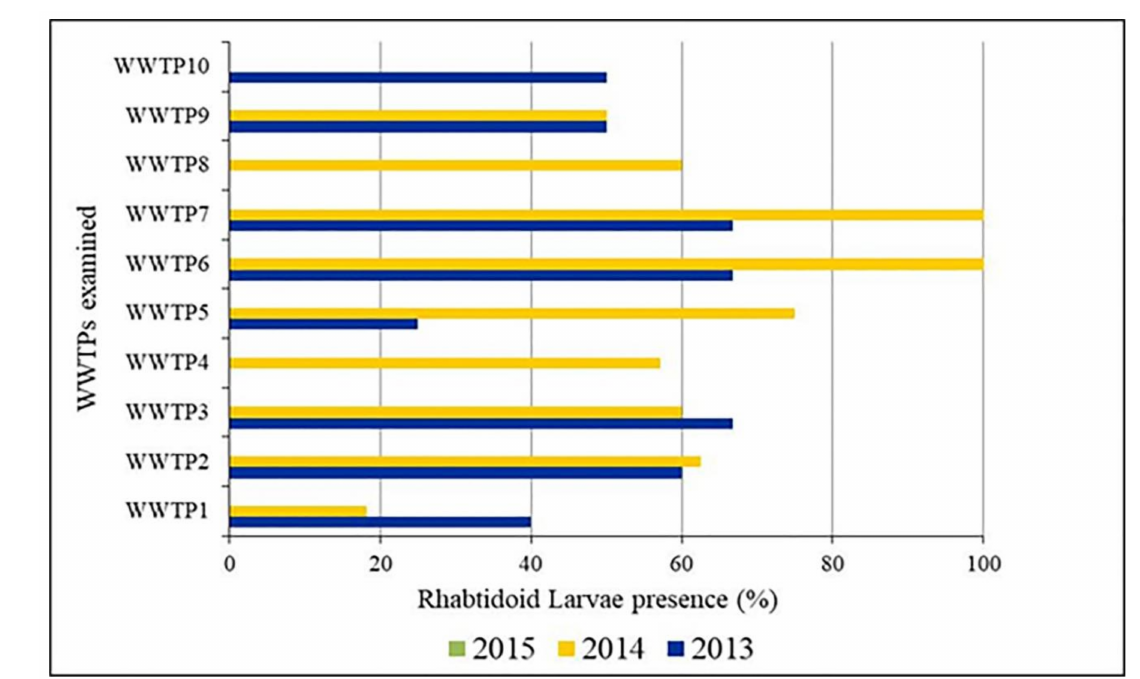
Figure 4. Percent presence of rhabditoid larvae of nematodes identified in dried sludge samples. During the study period, small fluctuations in the concentration of all helminth eggs were observed in the samples collected from the drying beds (Figure 6). Moreover, the mean helminth egg concentration during the three years of study for all investigated WWTPs was low and in the range of ≤ 1 egg/100 g DM according to WHO’s standards [11]. The arithmetic mean was obtained for 94.8% and 100% of samples except for Strongyloides eggs